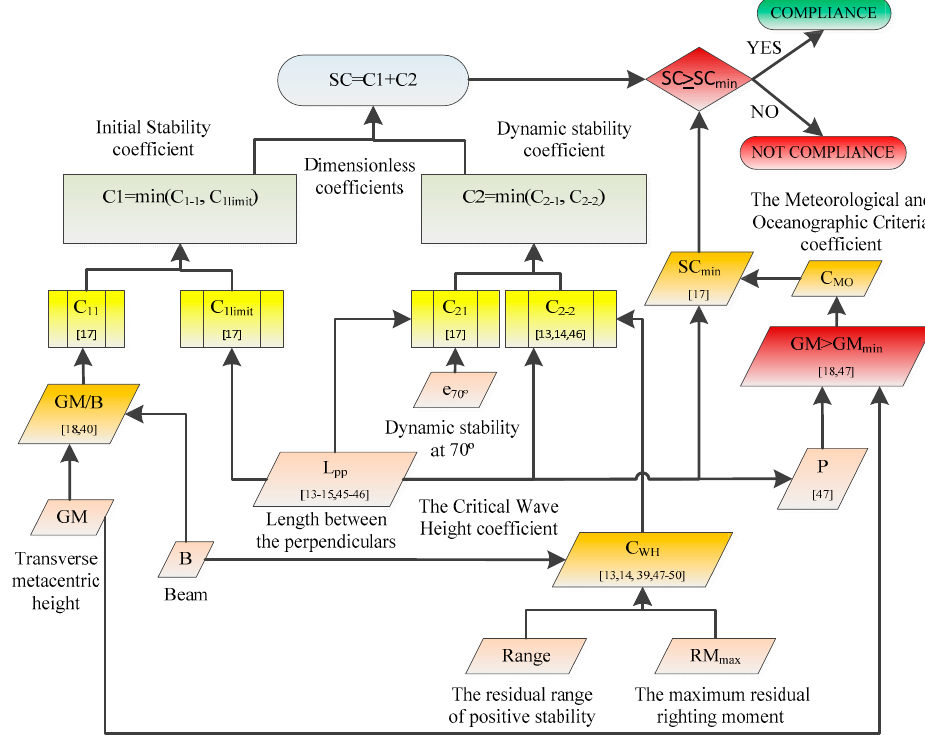
Figure 1. Proposed calculation procedure definition.